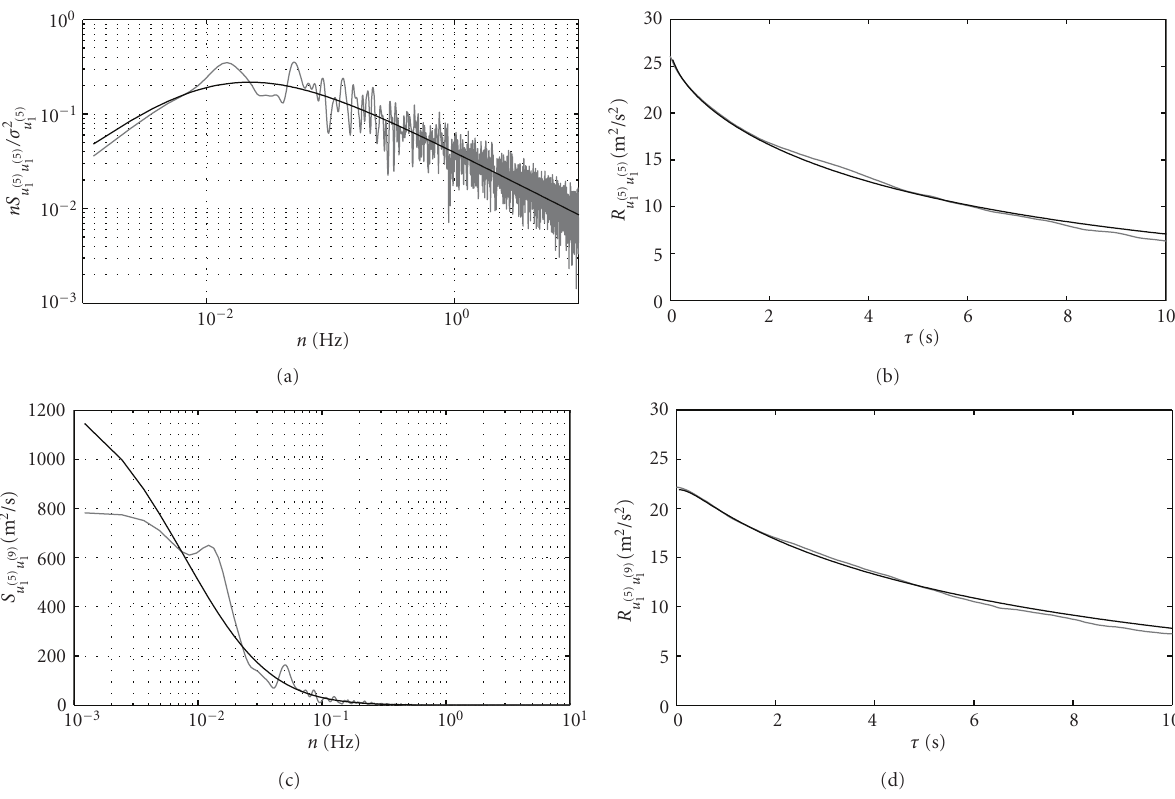
Figure 5: Example 1 using WAWS method (black lines denote target functions, gray lines denote numeric approximations): autospectrum of along-wind velocity at point 5 (a); corresponding autocorrelation function (b); cross-spectrum between along-wind velocities at points 5 and 9 (c); corresponding cross-correlation function